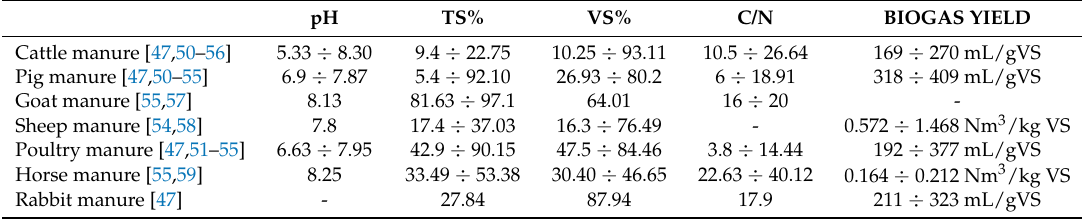
Table 4. Characteristics of manure from different livestock